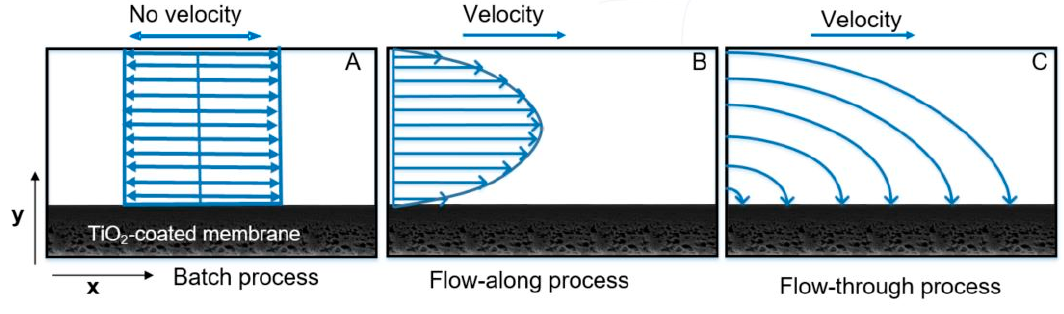
Figure 5. Velocityprofileofthesolutionindifferentreactors: ( A )batch; ( B )flow-along; and( C Figure 5. Velocity profile of the solution in different reactors: ( A ) batch; ( B ) flow-along; and ( C ) flow- through.